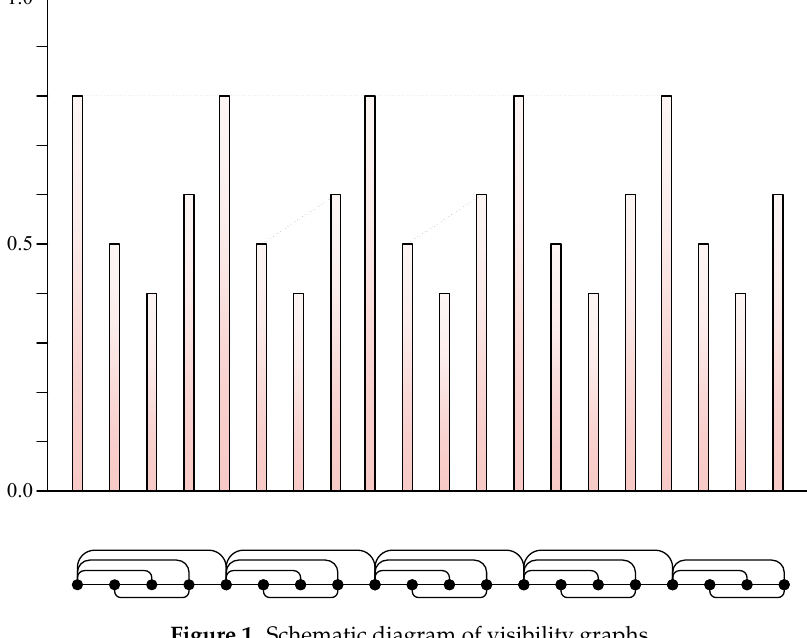
Figure 1. Schematic diagram of visibility graphs.